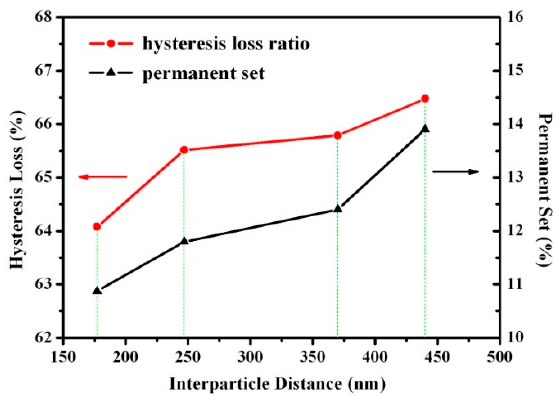
Figure 4. Hysteresis loss and permanent deformation as a function of interparticle distance ( ID poly ) .